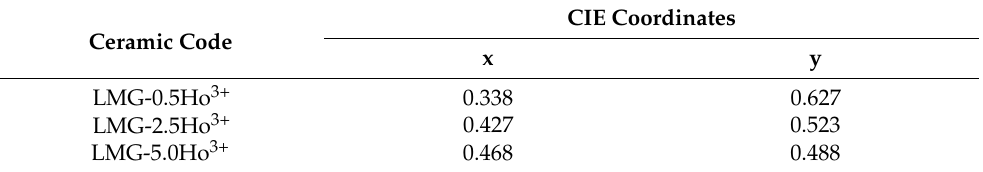
Table 1. The values of CIE chromaticity coordinates for LMG-Ho 3+ ceramic systems. Ceramic